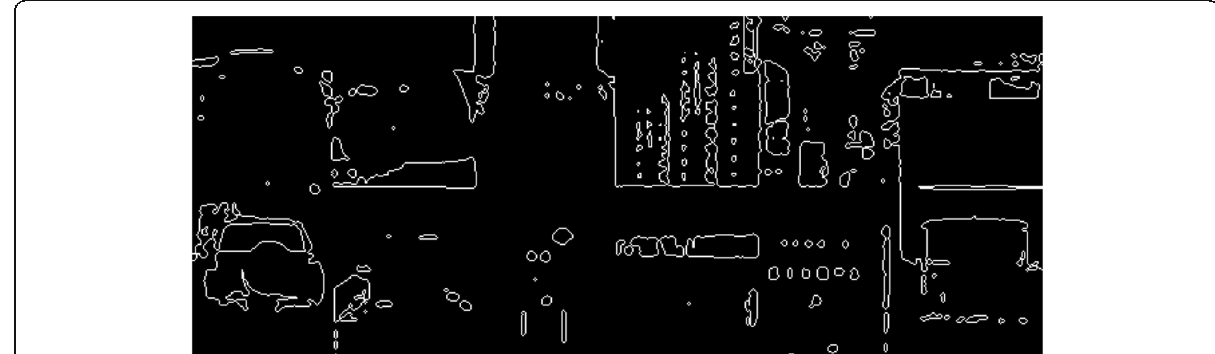
Fig. 12 Results of edge detection of obstacles ahead combined the gray average with the Laplacian operator